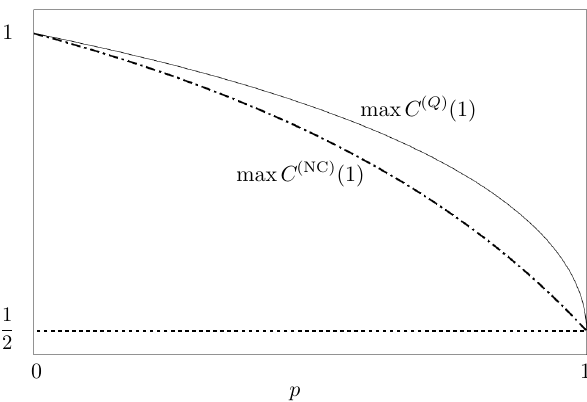
FIG. 5. An MCM for two states ρ 1 and ρ 2 in Eq. (18). An opti- mal POVM element | φ y (cid:13)(cid:14) φ y | for state ρ y for y = 1, 2 relies on the noise parameter p [see Eq.